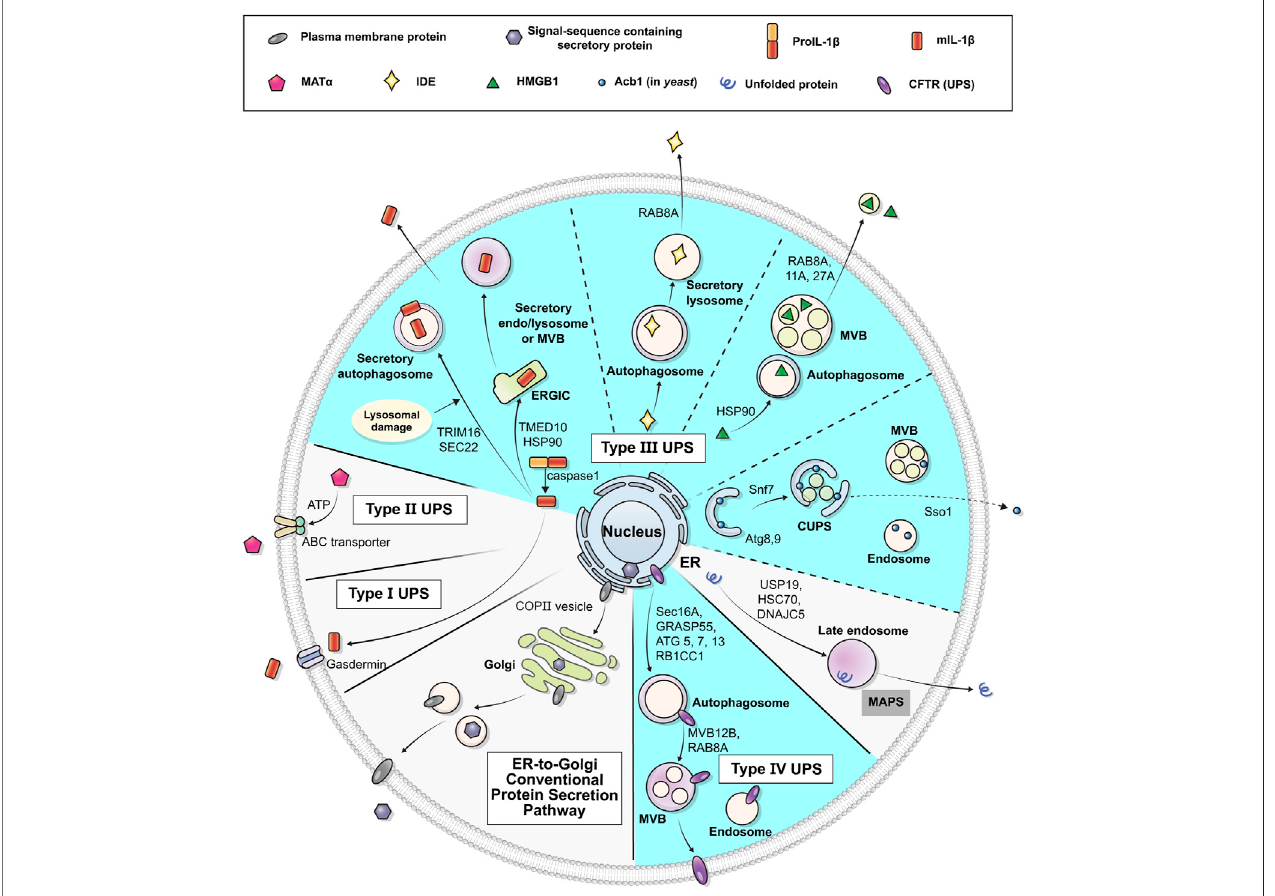
FIGURE1| Schematicrepresentation ofunconventionalprotein secretion.Transmembraneproteins andERluminal cytosolicproteins ingeneralpassthrough the ER and the Golgi apparatus in their route to their fi nal destinations (conventional secretion). Some leaderless cytosolic proteins can be secreted to extracellular space from cytosol via the membrane pore (Type I UPS), ABC-transporter (Type II UPS), or vesicles (Type III UPS). Some transmembrane proteins may alternatively be transported to the plasma membrane via an unconventional secretory pathway that bypasses the Golgi (Type IV UPS). Diverse vesicular systems, including autophagosomes,multivesicularbodies(MVBs)andCUPS,areinvolvedinthetypeIIIandIVUPSpathways.TheUPScargosutilizingautophagymachineriesaremarked in cyan (see text for details).